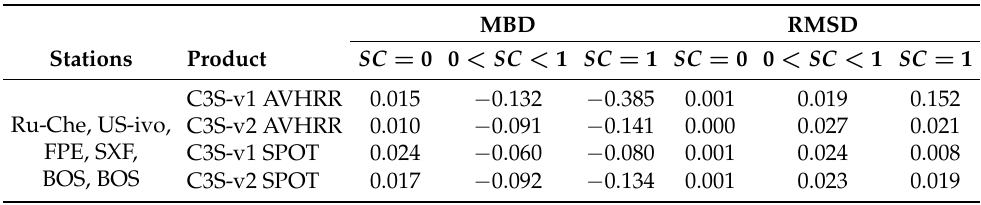
Figure A1. Monthly variation of mean bias deviation (MBD) and root mean squared deviation (RMSD) of monthly blue-sky albedo estimations for the different snow cover conditions from 2000/02 to 2005/12, i.e., overlap period between C3S-AVHRR and C3S-SPOT. Stations are sorted top-down by decreasing latitude. Table A1. Summary metrics (median MBD and median RMSD) of products from 2000/02 to 2005/12 at the stations where all products are simultaneously available during that period (Ru-Che, US-Ivo, FPE, SXF, BOU,